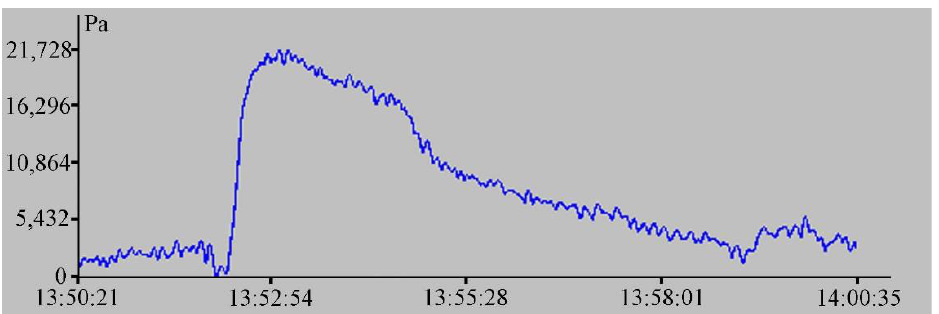
Figure 10. A section of the recording of the supersensitive detector of hydrosphere pressure variations for 1 June 2021, installed on the seabed at Cape Shultz, showing a nonlinear hydrophysical disturbance corresponding to a rogue wave of the “ hump ” type.